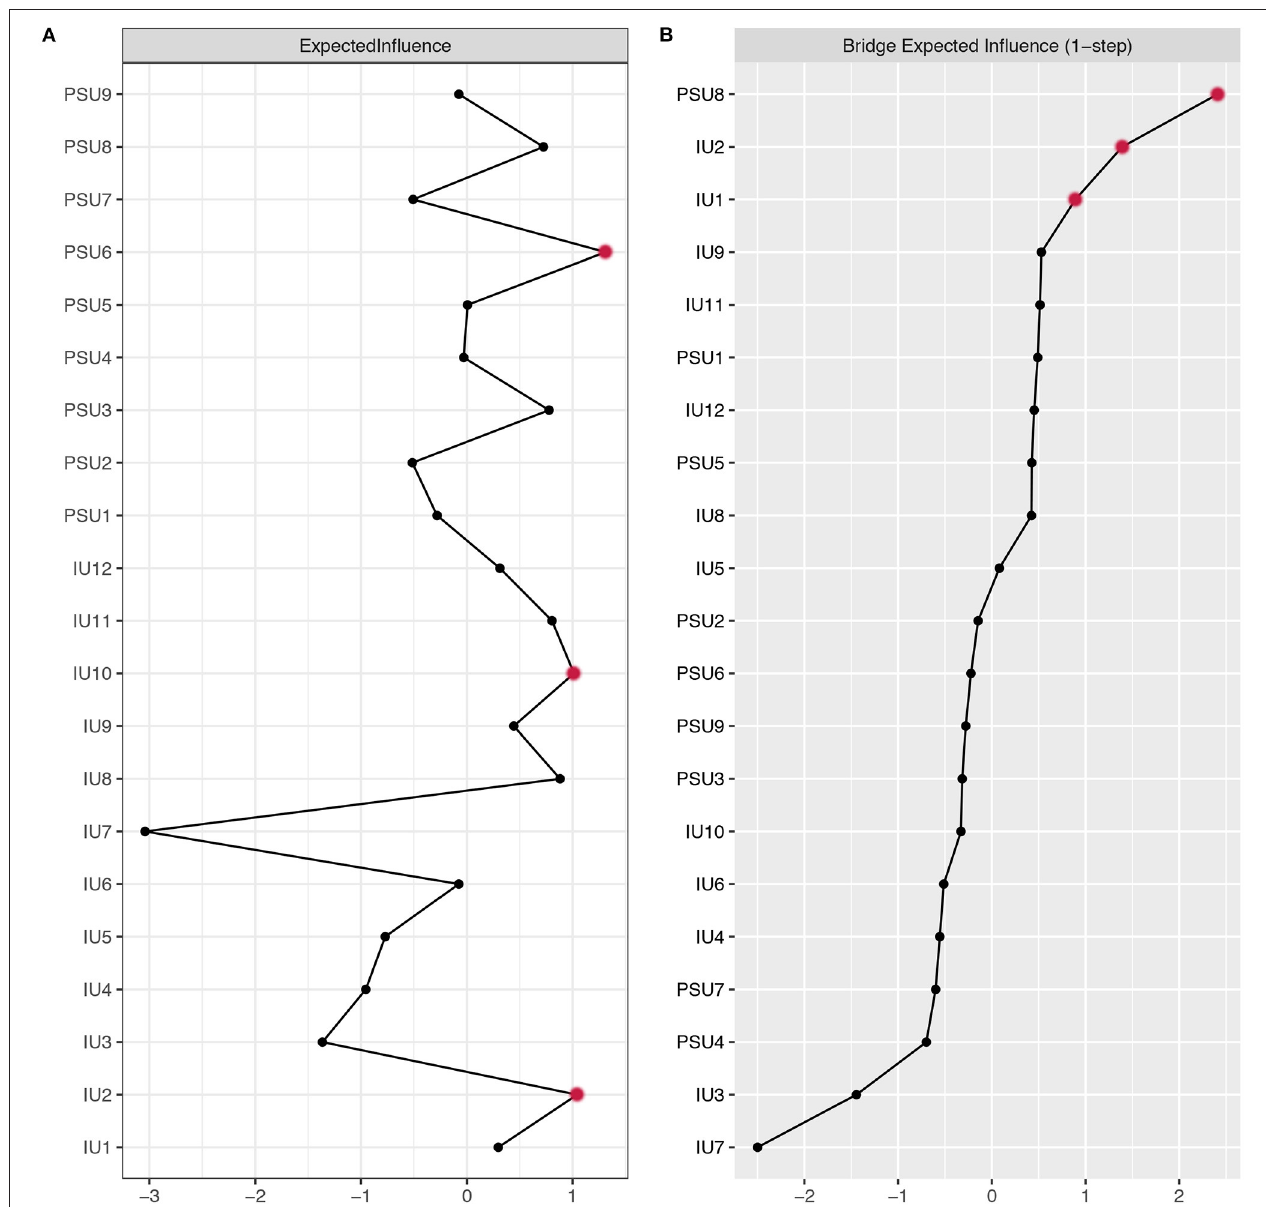
FIGURE 2 | Centrality plot depicting the (A) expected influence and (B) bridge expected influence of each variable selected in the present network ( z -score). The text of variables selected in network can be seen in Table 1